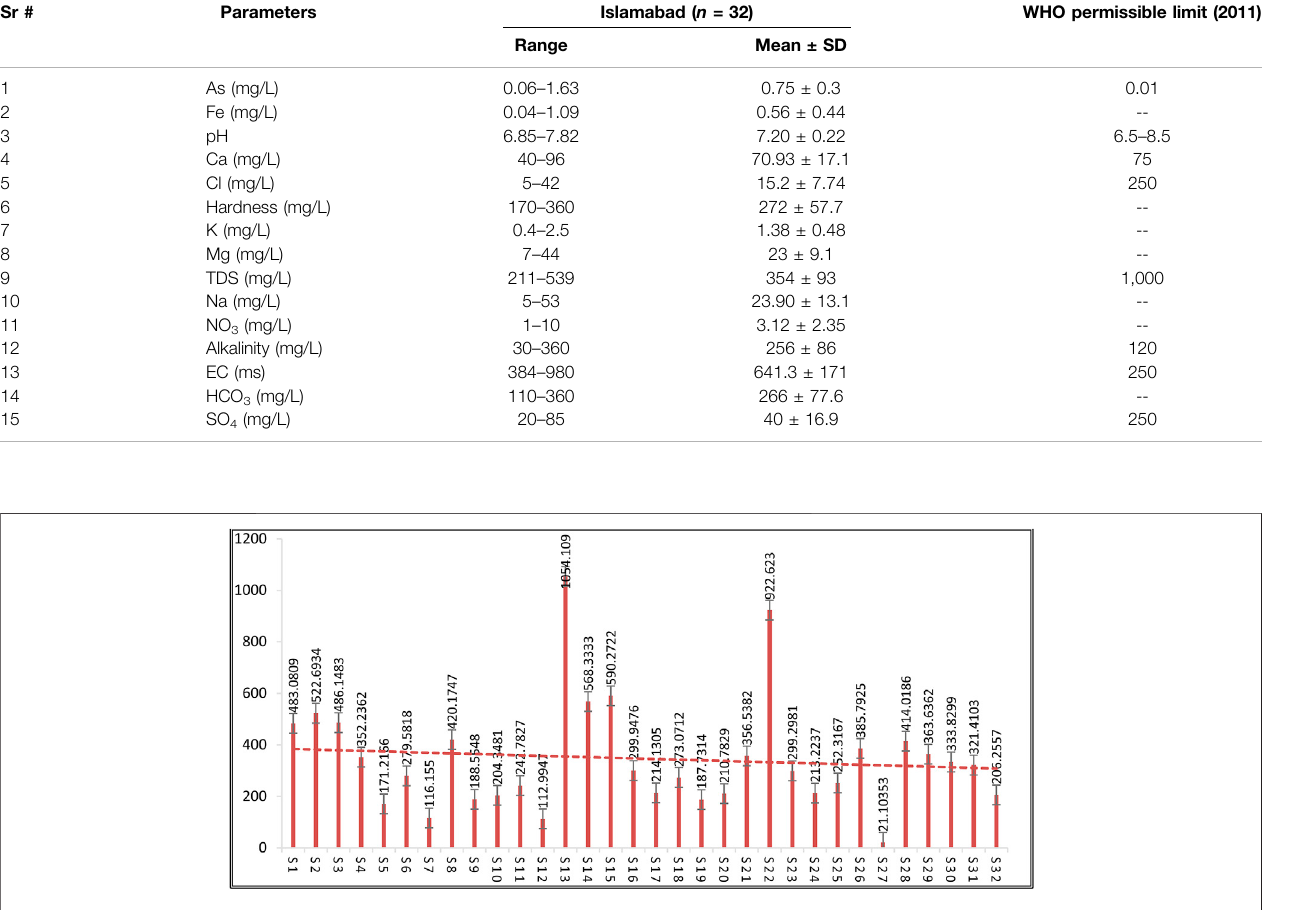
FIGURE 3 | WQI of particular sites in Islamabad.